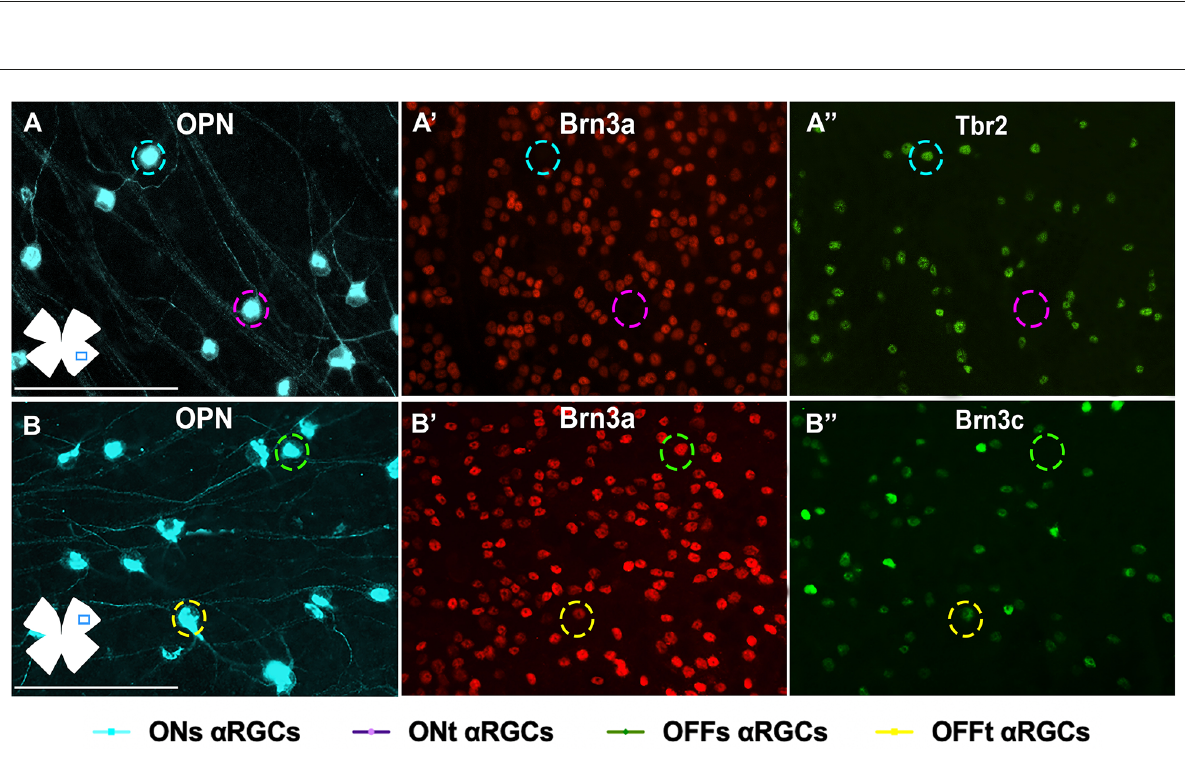
FIGURE7 Immunohistochemical identification of α RGC types in flat-mounted retinas. Magnifications of flat-mounted retinas immunodetected against OPN, Brn3a, and Tbr2 (A–A (cid:48)(cid:48) ) to identify ONs- α RGCs (OPN + Brn3a − Tbr2 + , blue traced circle), and ONt- α RGCs (OPN + Brn3a − Tbr2 − , pink traced circle) and against OPN, Brn3a, and Brn3c (B–B”) to identify OFFs- α RGCs (OPN + Brn3a + Brn3c − , green traced circle) and OFFt- α RGCs (OPN + Brn3a + Brn3c + , yellow traced circle). Scale bar: 100 µ